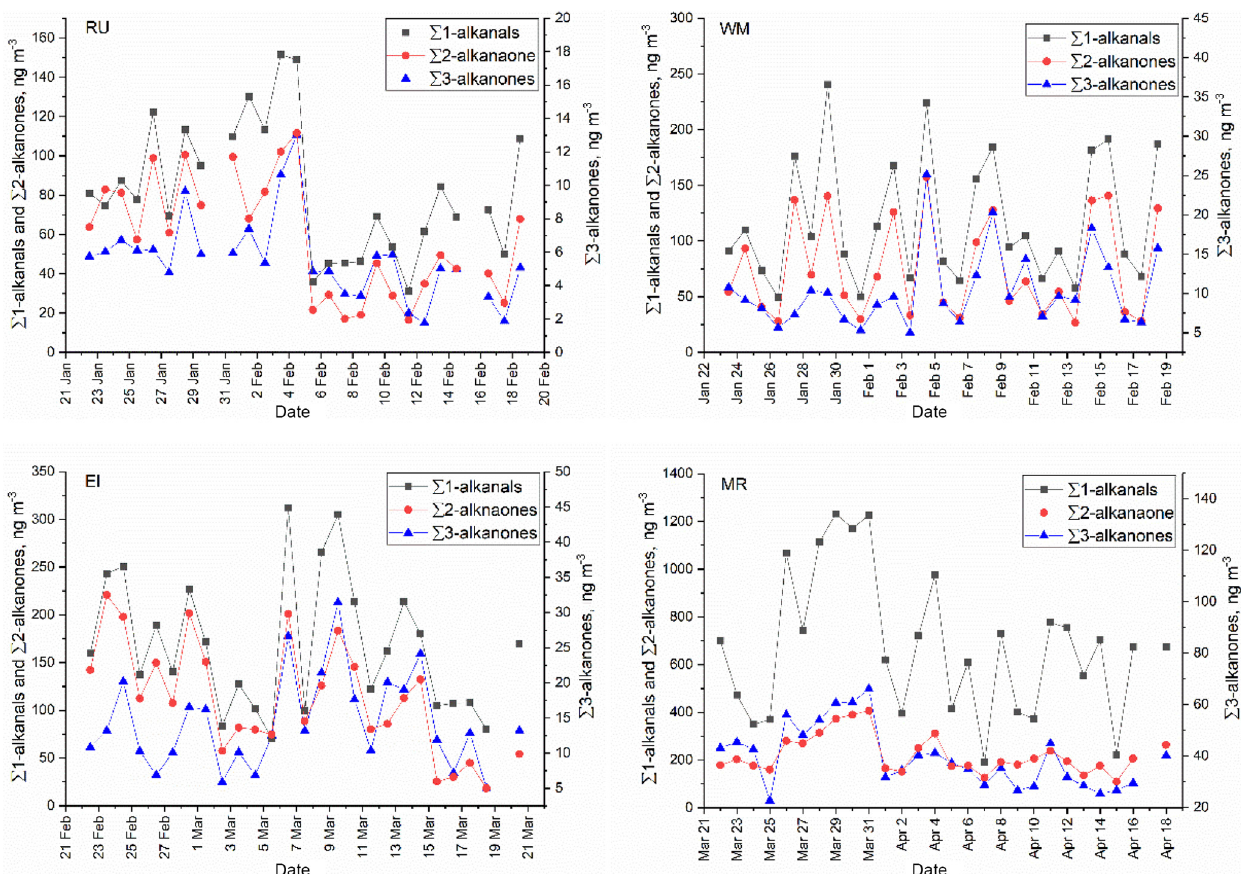
Figure 2. Time series of particle-bound P n -alkanals, P n -alkan-2-ones, and P n -alkan-3-ones at the RU, WM, EL, and MR sites.